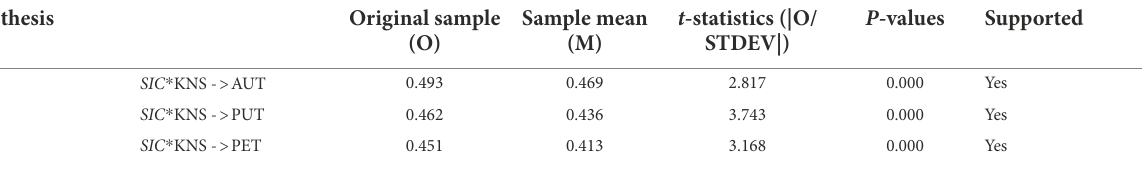
TABLE 11 Moderation analysis